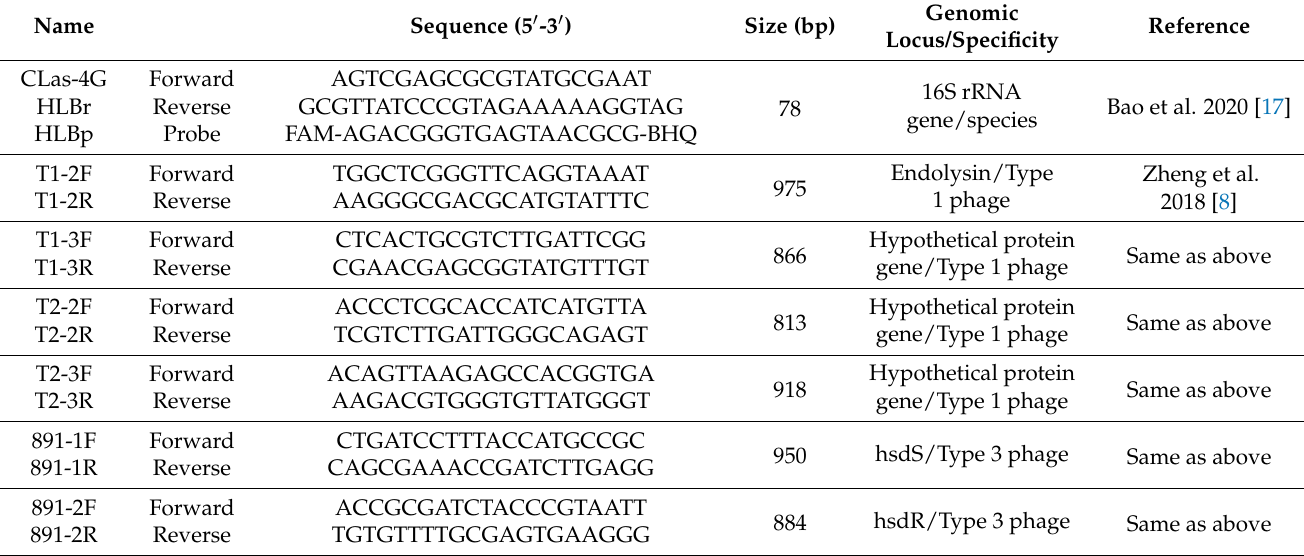
Table 1. A list of PCR primers for detection of “ Candidatus Liberibacter asiaticus” (CLas) and CLas phages used in this study.